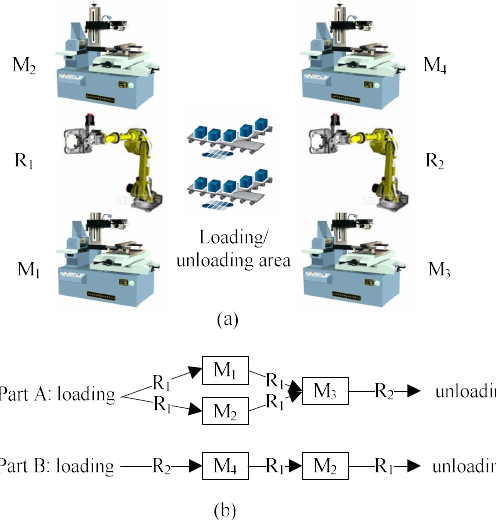
Figure 15. ( a ) An AMS example and ( b ) production sequence.